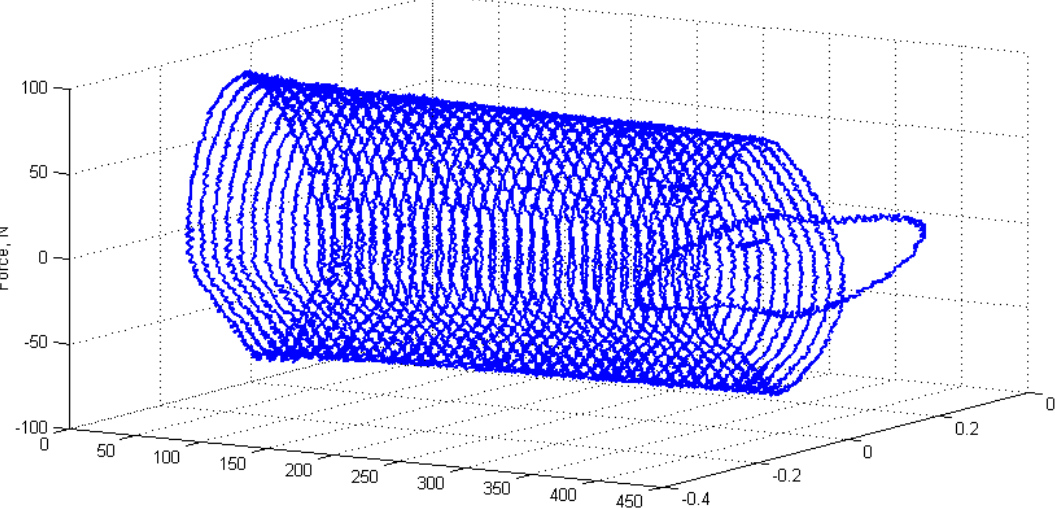
Figure 1. Experimental example of a hysteresis loop evolution during the appearance of the self-heating effect in a polymer matrix composite (PMC) structure under cyclic loading.